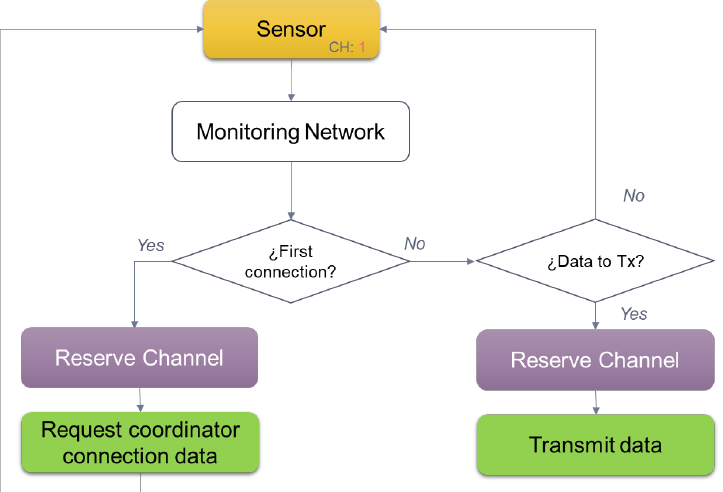
Figure 10. Sequence for the reservation of the medium by a sensor in the Zigbee